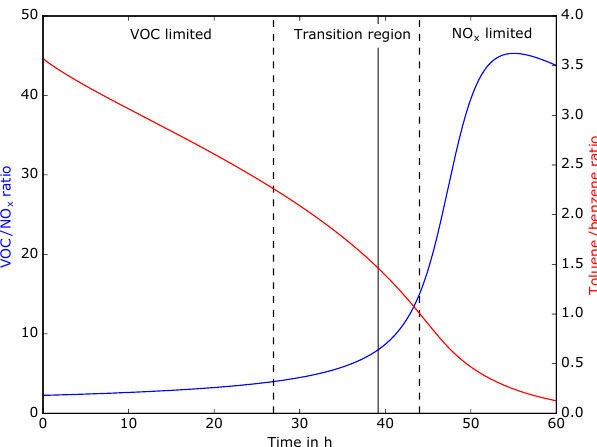
Figure 3. Temporal evolution of the VOC / NO x (blue line) and toluene / benzene (red line) ratios over 60h derived from MOZART-T1